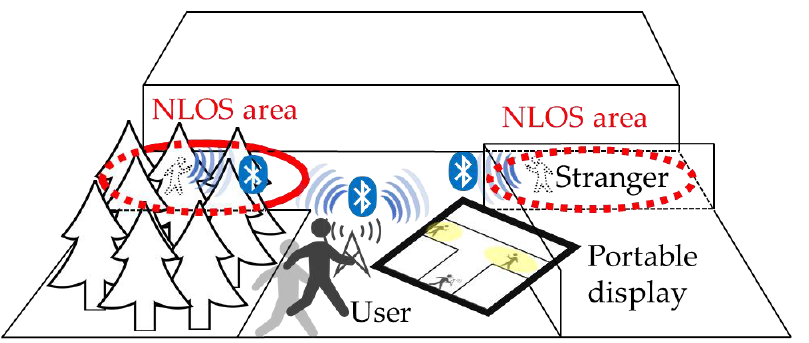
Figure 1. Conceptual diagram for human-to-human position estimation system using RSSI in an outdoor environment (NLOS area). User is the receiver and has a portable display map that estimates the location of surrounding strangers; transmitter, from RSSI values.